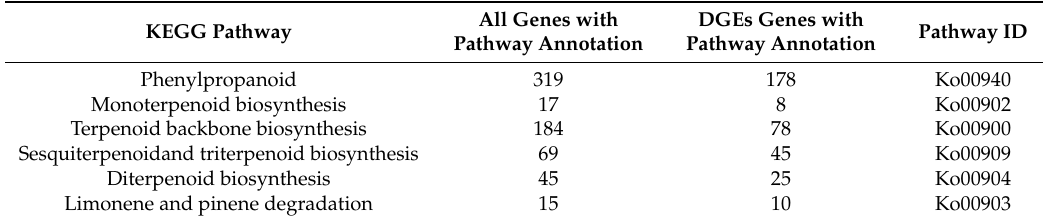
Table 3. The KEGG enrichment of DEGs among the three flowering stages.